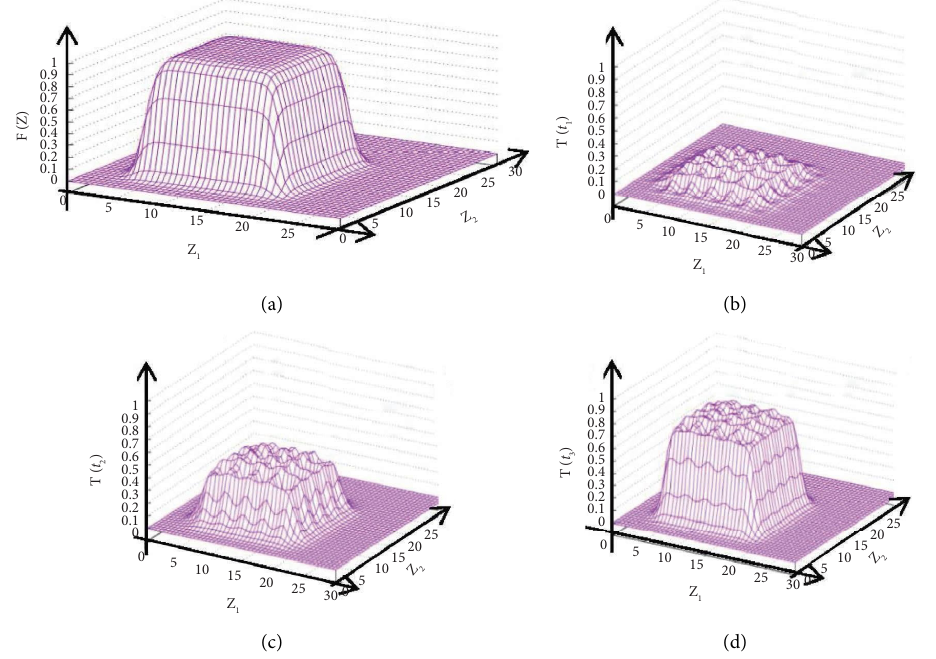
Figure 11: Evolution of the state of an object, t